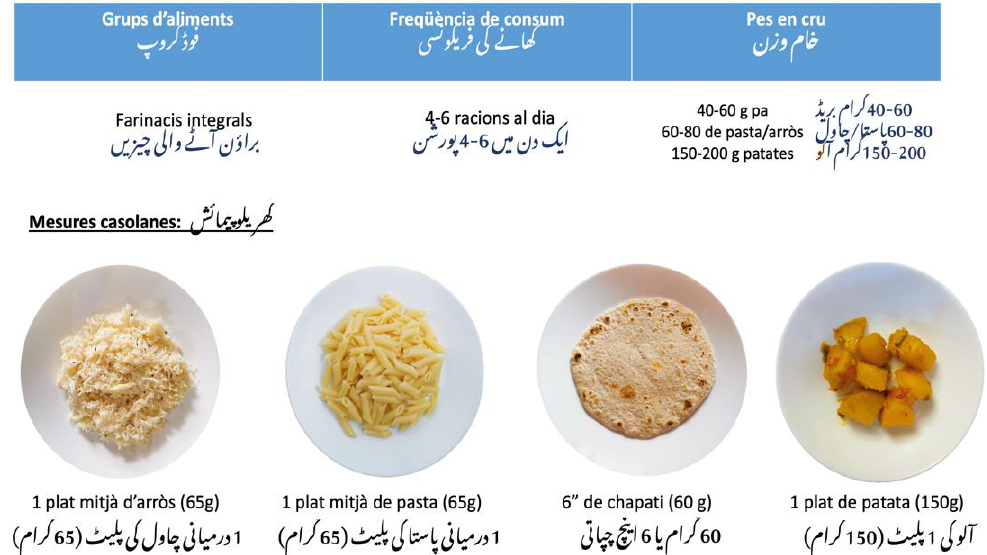
Figure 2. Example of the explanation for serving size and frequency of